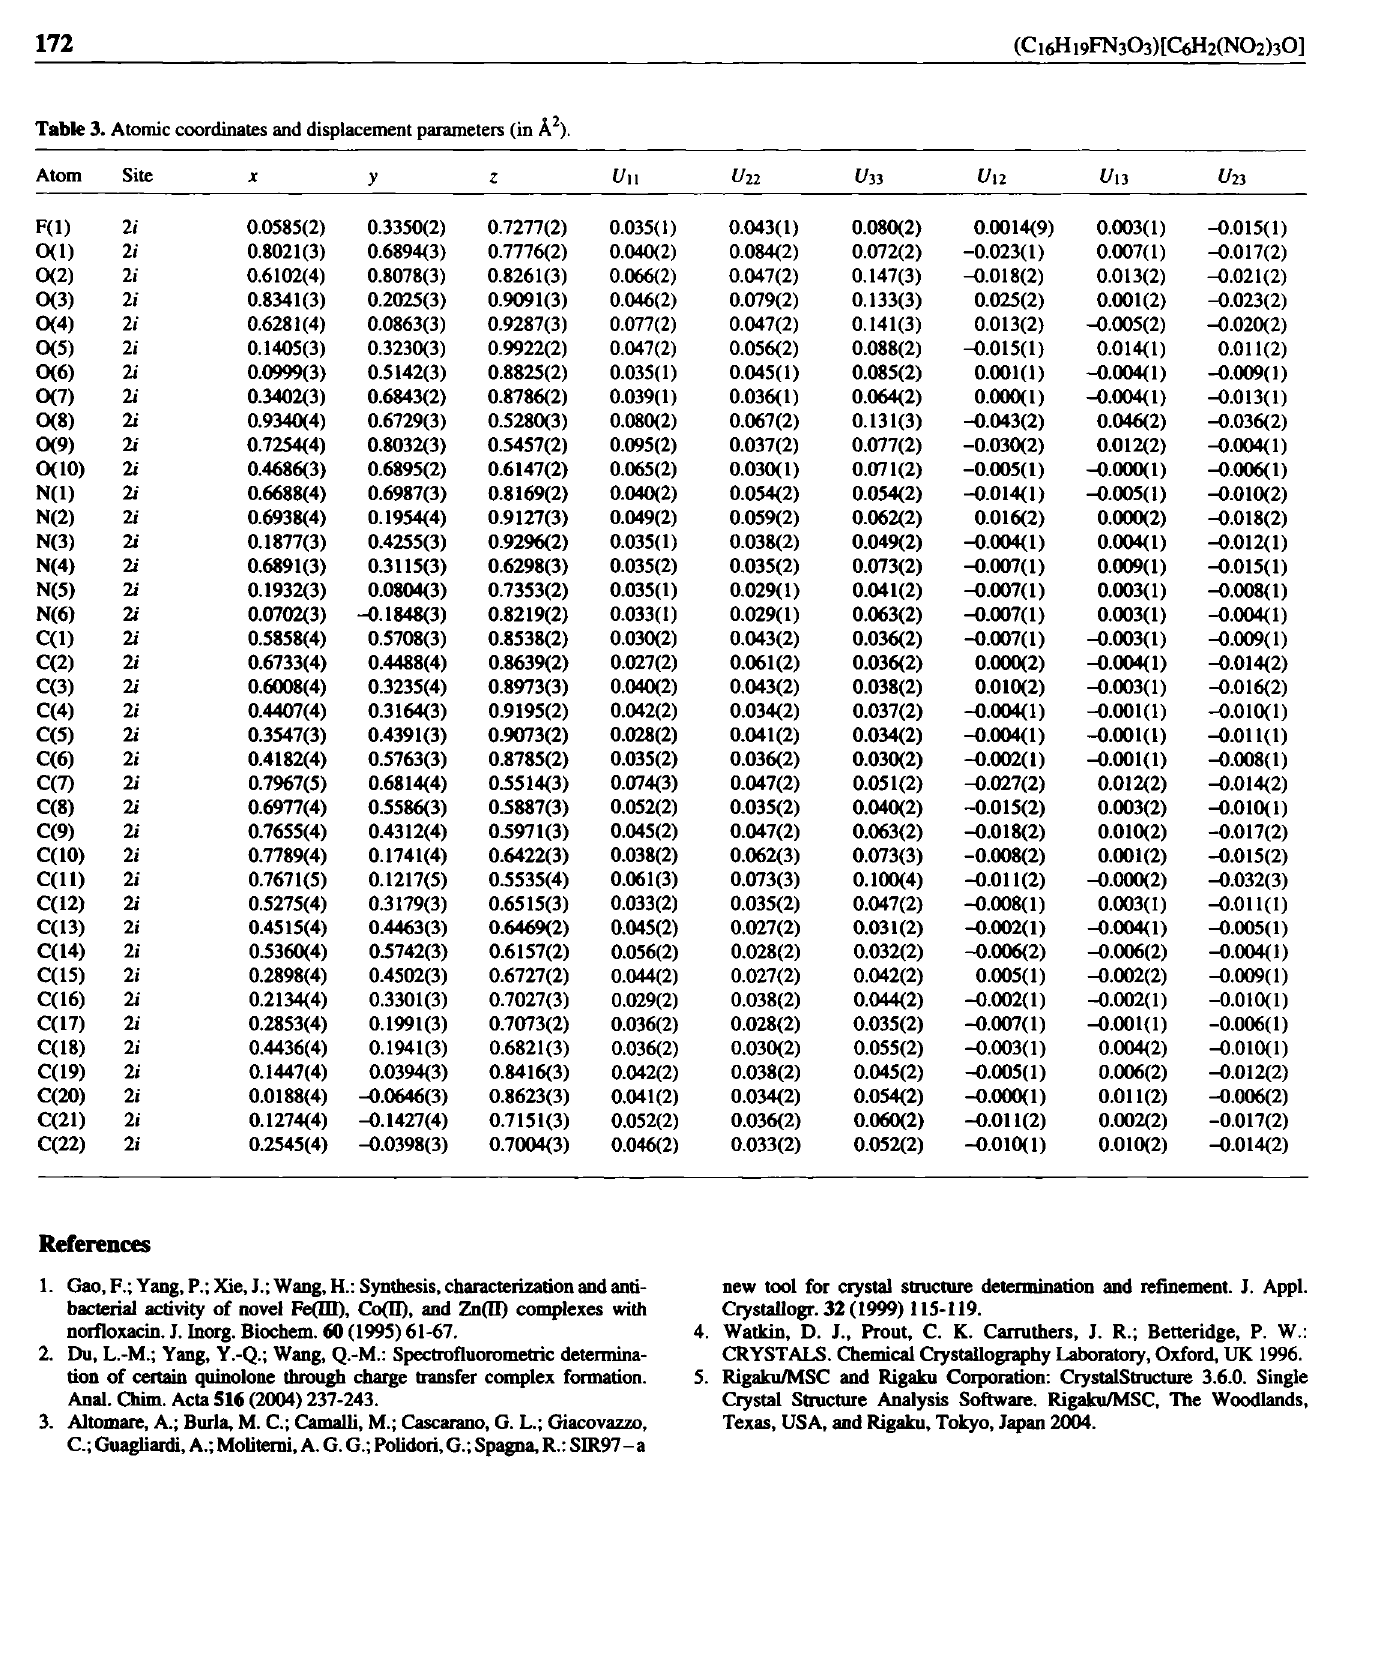
Table 3. Atomic coordinates and displacement parameters (in A 2